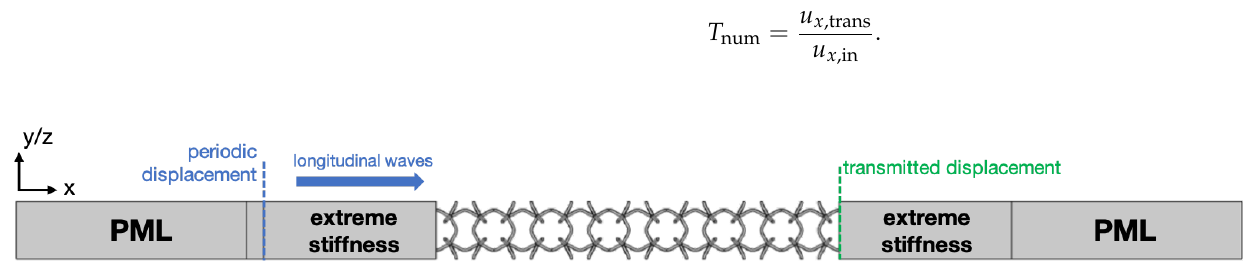
Figure 3. Setup for the transmission simulation. Longitudinal waves are transmitted from left to right. The excitation of the waves is guaranteed to be perfectly longitudinal by domains of extreme stiffness. Perfectly matched layers (PMLs) prevent artifacts from reflections. The transmitted displacement is evaluated at the interface between the cellular array and second extreme stiffness domain. Periodic conditions are applied in y- and